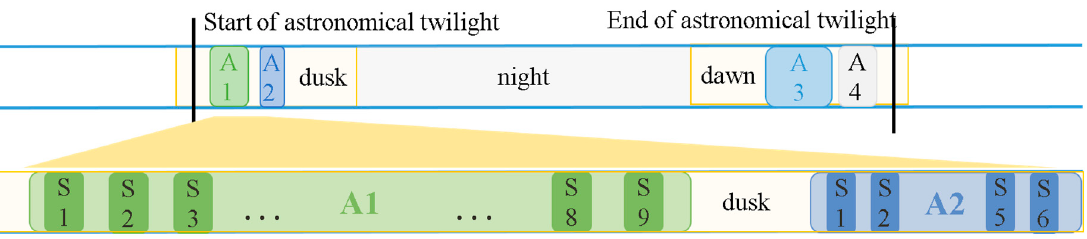
Figure 7. Optical observation schedule of the OWL-Net. Constraints of the observable time: Sun elevation angle (astronomical twilight, − 12 degrees), target satellite elevation angle, and lighting condition (penumbra and direct Sun). During the observable time span (A1, A2, etc.), several shots (S1, S2, etc.) could be achieved with charge-coupled device (CCD) readout and mount moving time.